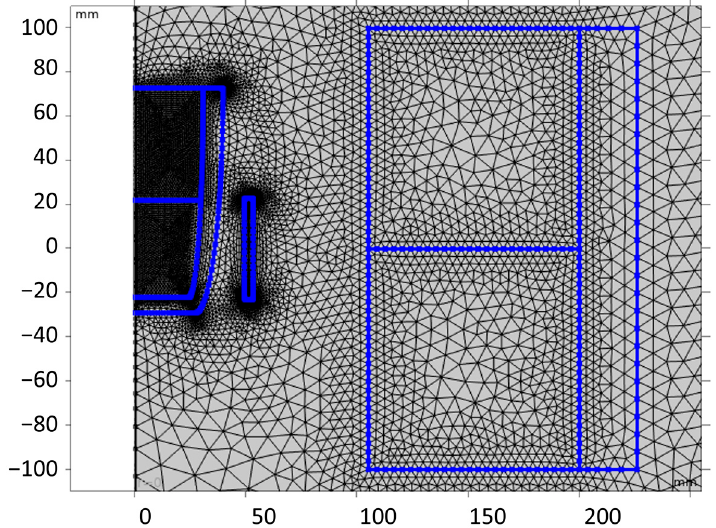
Figure 3. Meshed geometry of the liquid metal crucible and induction coil inside the permanent magnet system.